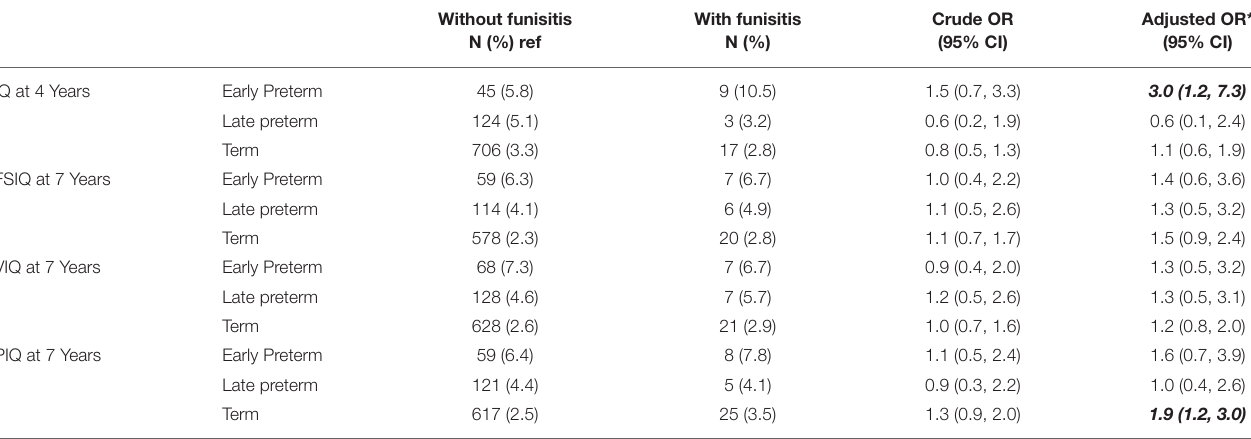
TABLE 2 | Risk of low IQ (score < 70) # at age 7 years in children with